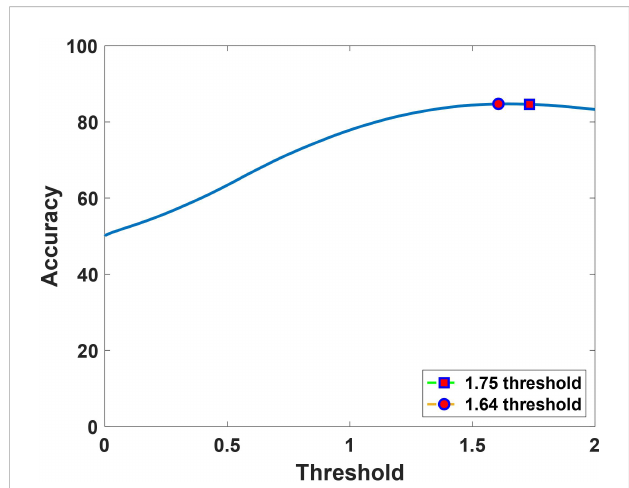
FIGURE 3 Accuracy as a function of the dual-echo derived sRCBV threshold, showing that the computed optimal upper threshold, 1.64 (marked in circle) has consistent accuracy (84%) with the reference value, 1.75 (marked in square).